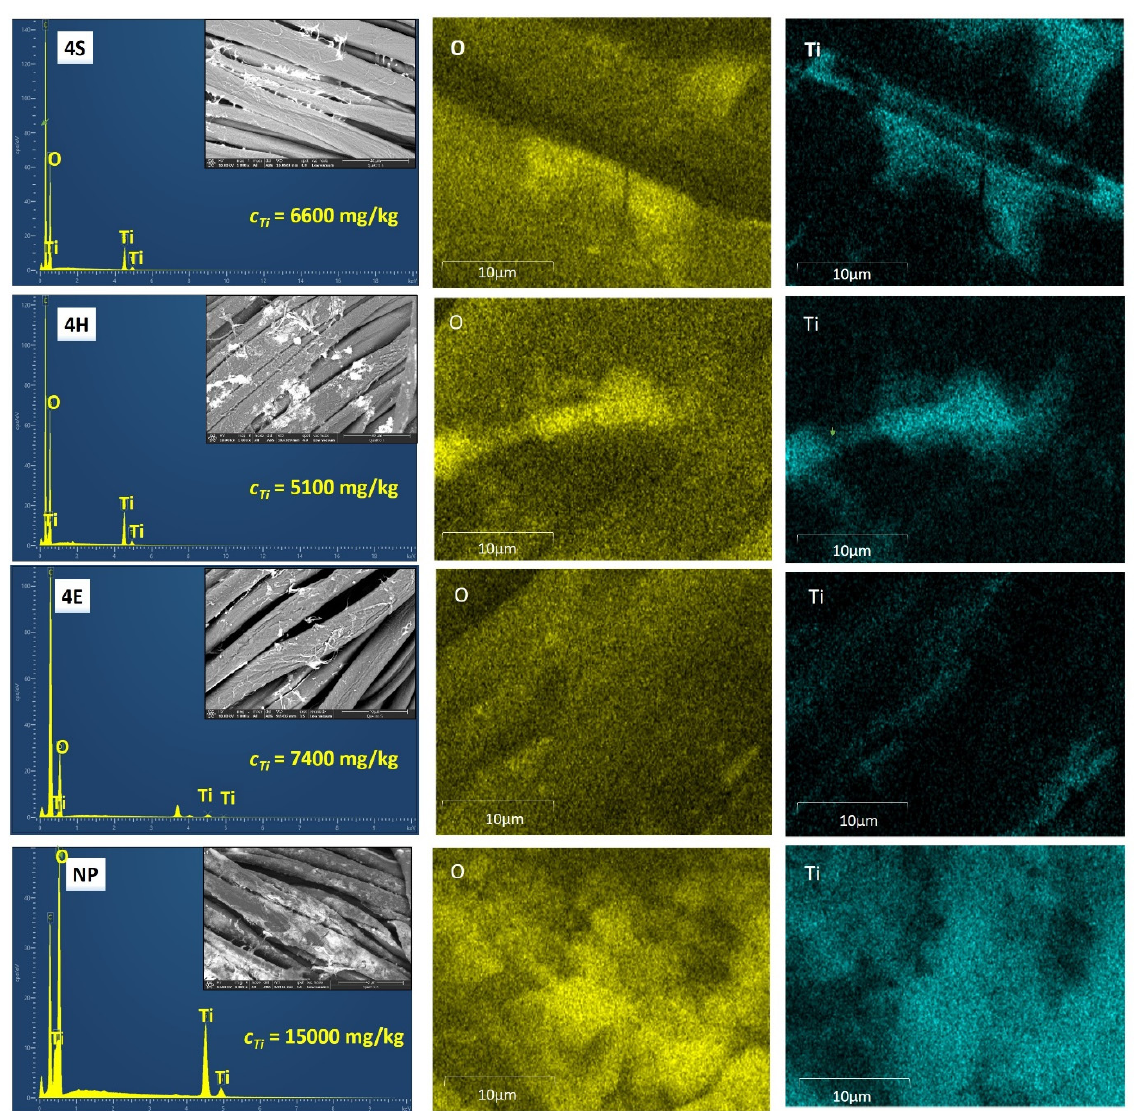
Figure 2. EDS spectra and EDS mapping of the TiO 2 treated cotton samples using 4% titanium isopropoxide in the nanosol applied via the sol–gel pad–dry–cure (4S), pad–hydrothermal (4H), and